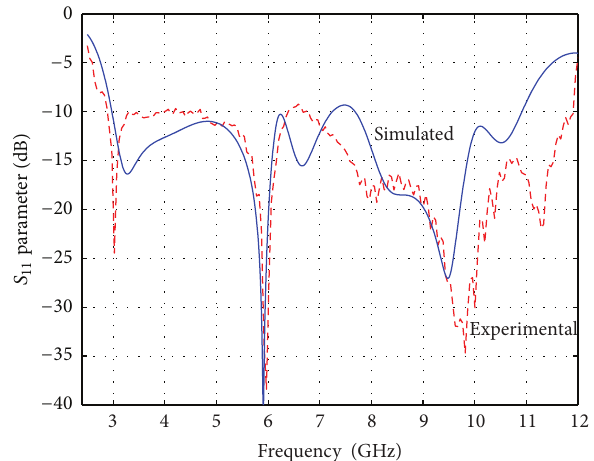
Figure 4: Simulated and experimental reflection ( 𝑆 11 ) responses of the designed UWB